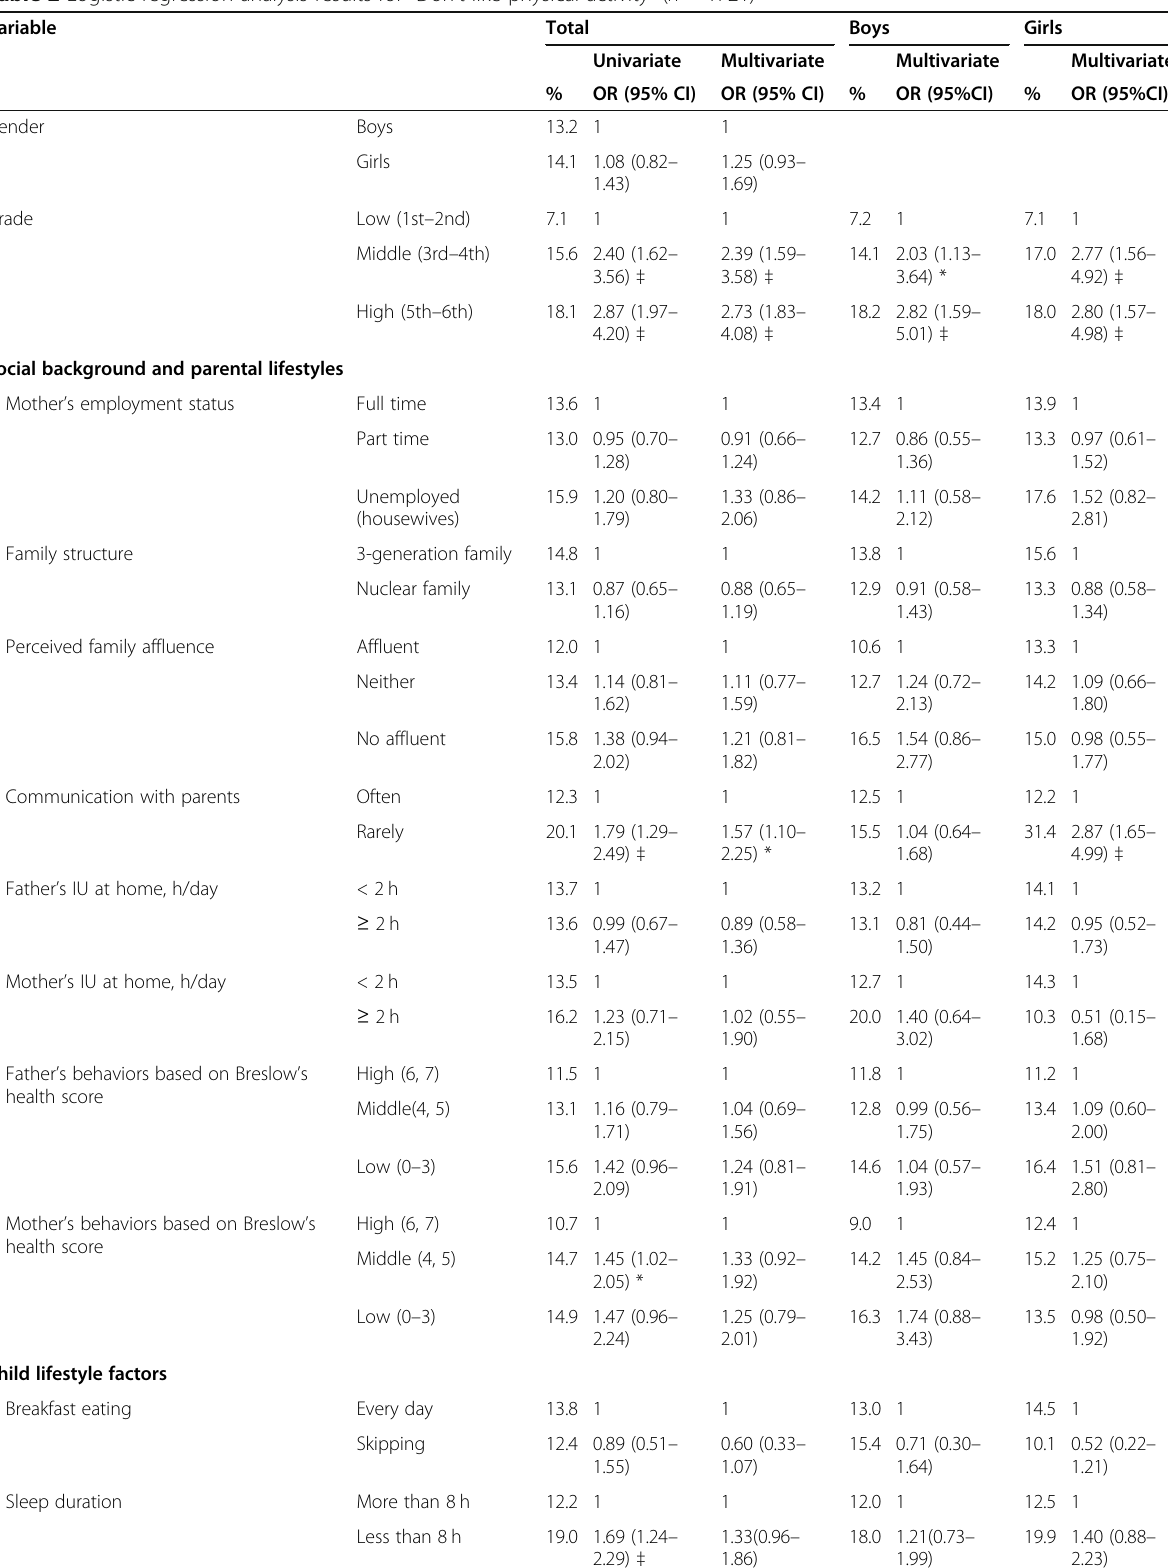
Table 2 Logistic regression analysis results for “ Don ’ t like physical activity ” ( n =